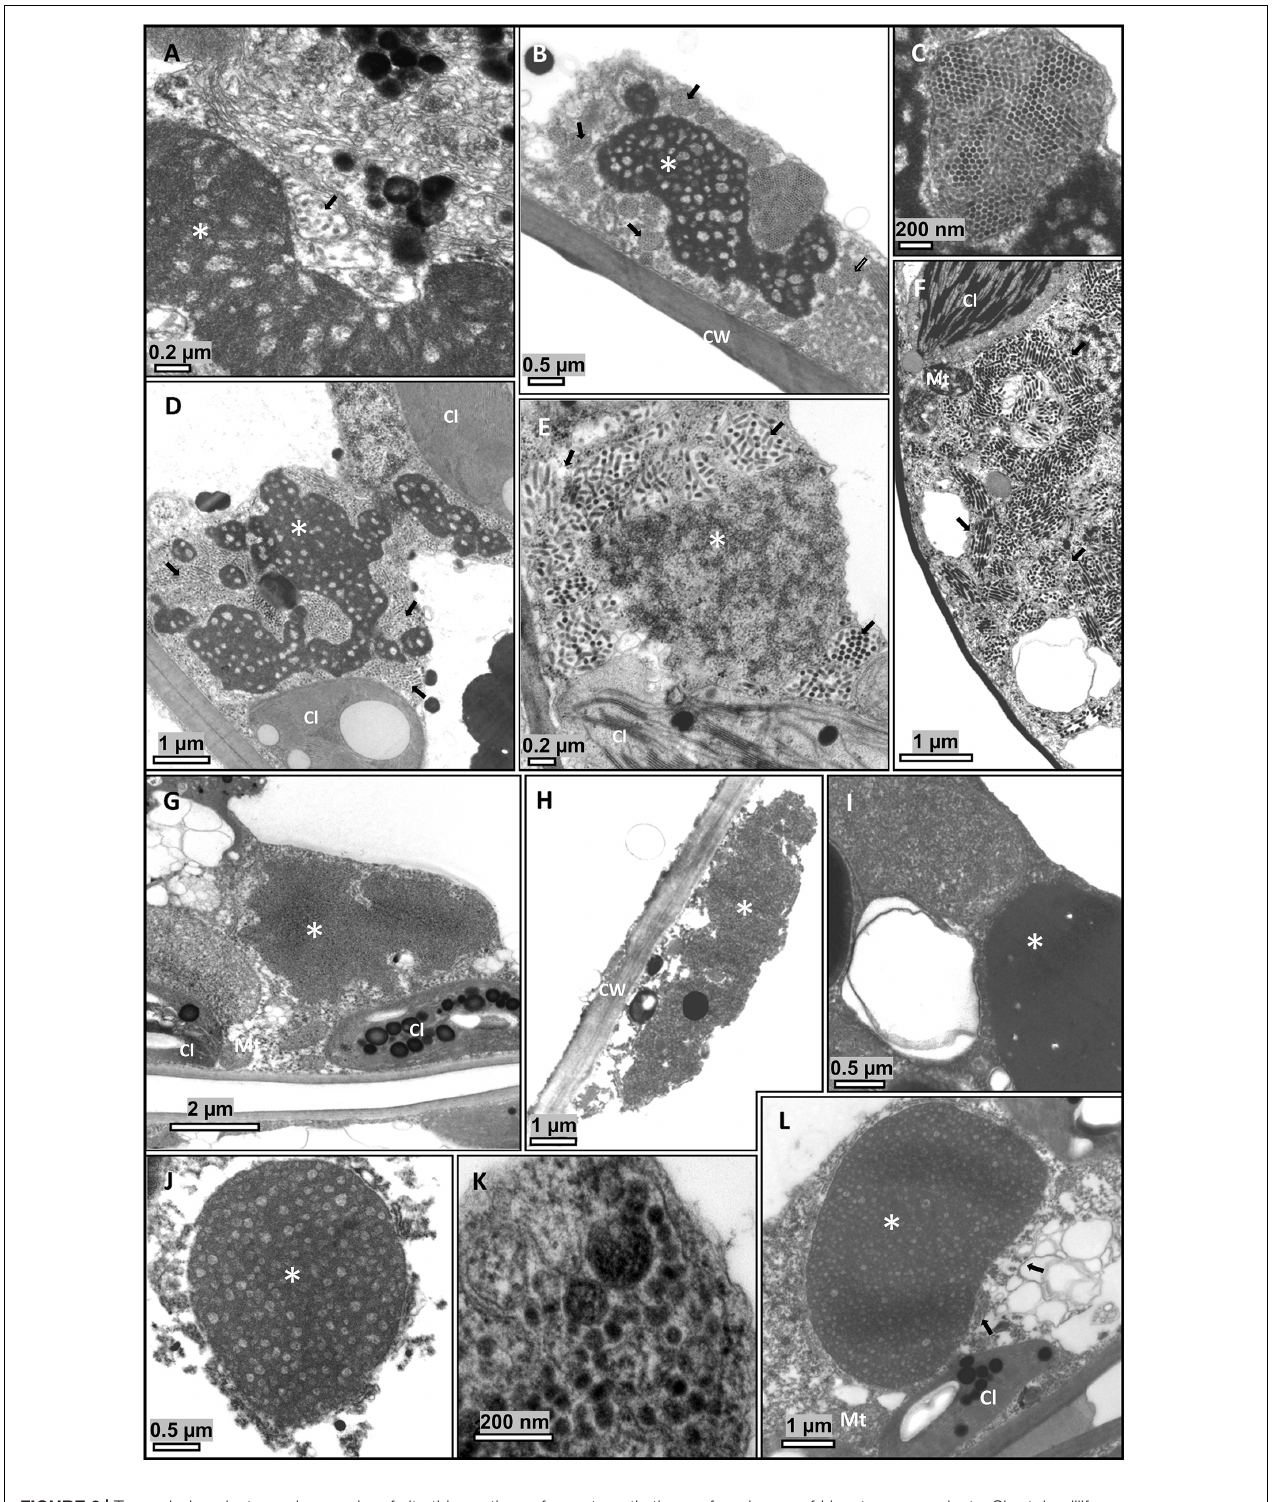
FIGURE 2 | Transmission electron micrographs of ultrathin sections of symptomatic tissues from leaves of Ligustrum spp. plants. Short, bacilliform, membrane-bounded particles, presumed virions, are usually observed close to the viroplasm, contained in membrane-bound cisternae of the endoplasmic reticulum. (A–C) Ligustrum lucidum, sample Crb1. (D–F) L. japonicum, sample Crb2. (G–I) L. sinense, sample Cdb1. (J–L) L. japonicum, sample SPa1. (A–L) Electron dense, vacuolated masses of varying shapes and bacilliform particles are observed in the cytoplasm of cells of the epidermis, mesophyll parenchyma, and, occasionally, in the xylem parenchyma. (G–H) Non-vacuolated viroplasms. Cl, chloroplast; CW, Cell wall; Mt, mitochondrion; V, virion. *Viroplasm.